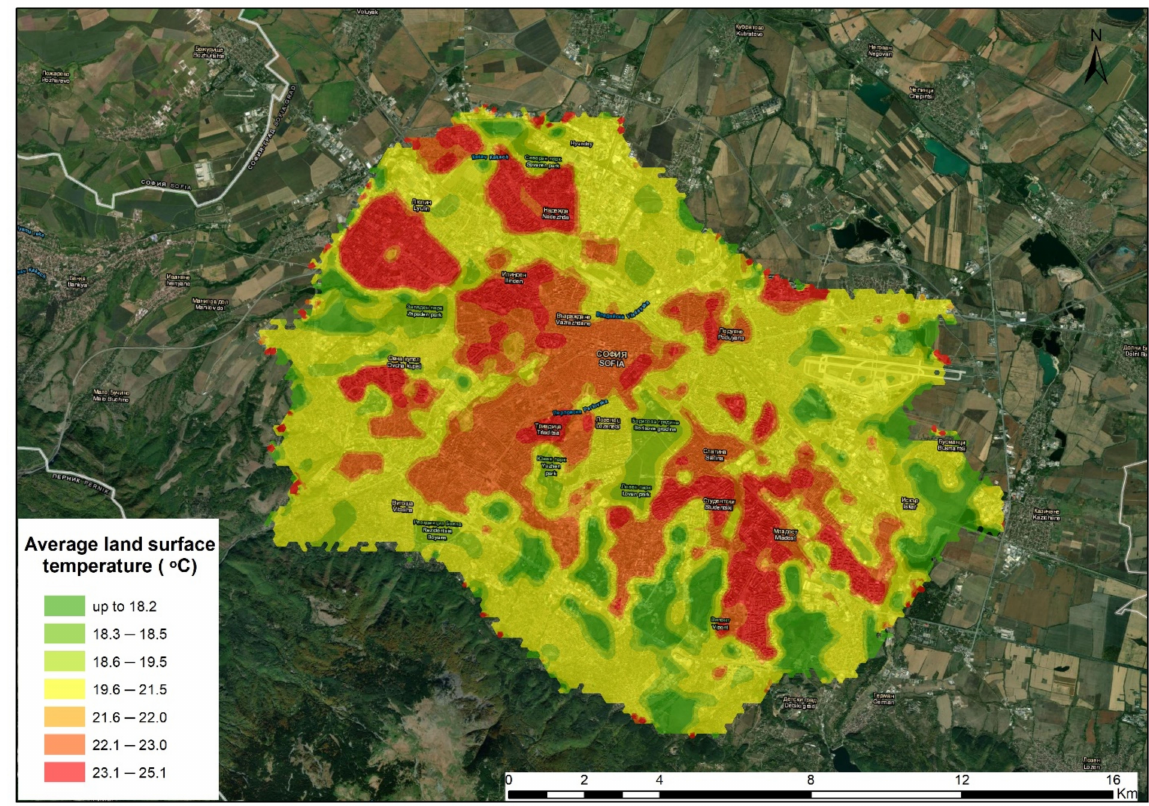
Figure 6. Map of the spatial distribution of calculated and interpolated land surface temperatures (LSTs) in Sofia between 8:00 p.m. and 10:00